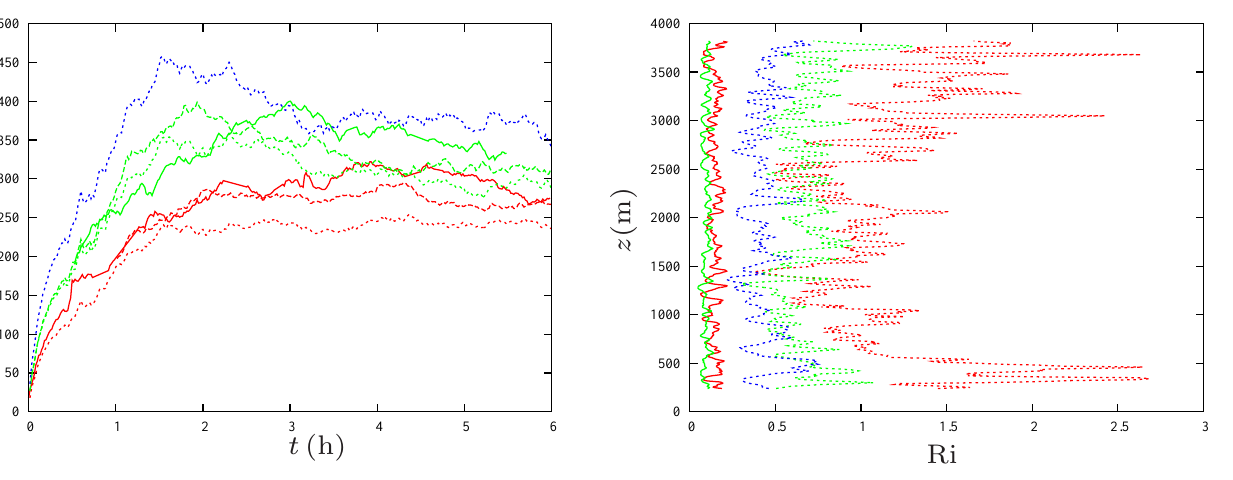
Figure 9. Vertical distribution of Ri for the weak forcing cases (red lines); moderate forcing cases (green lines); and strong forcing case (blue line). Solid lines: 1 = 2m; dotted lines: 1 = 10m.